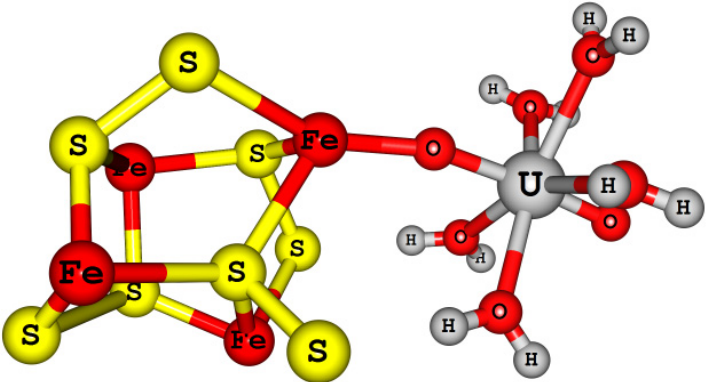
S -UO (H O) ] 2+ ) 4 8 2 2 5